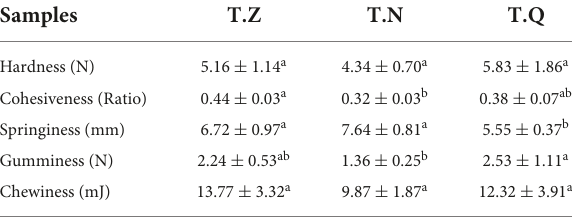
FIGURE2 Hairtail muscle nutrient content from three different sources.